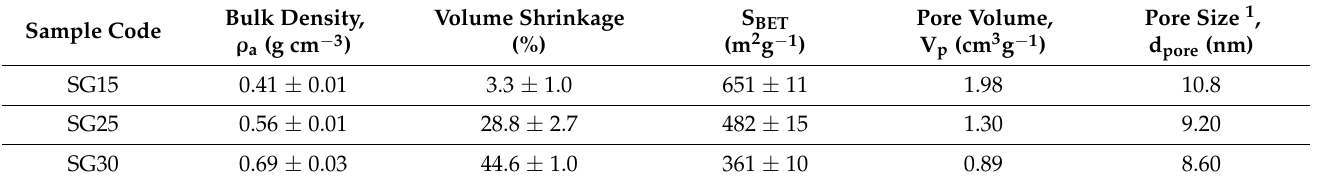
Table 2. Bulk density, volume shrinkage and textural parameters (S BET specific surface area, specific porous volume and pore size) were measured for the different hybrid aerogels obtained as a function of the gelatin content.